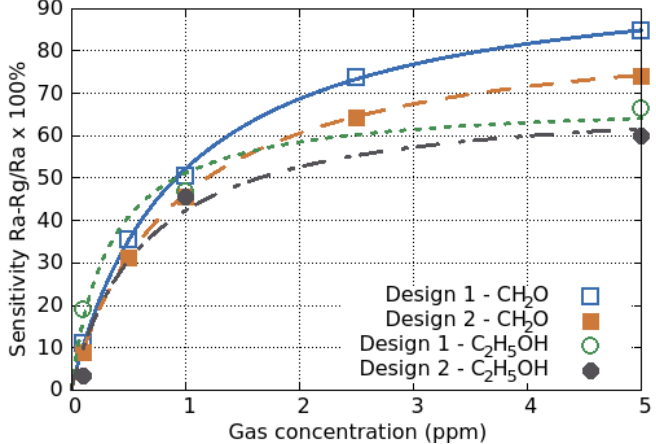
Figure 19. Sensing response of two different designs towards exposure to formaldehyde (CH 2 O) and ethanol (C 2 H 5 OH) concentrations up to 5 ppm on an SnO 2 film with Pt nanoparticles. The symbols are measured results and lines are best fits lines using the Langmuir adsorption